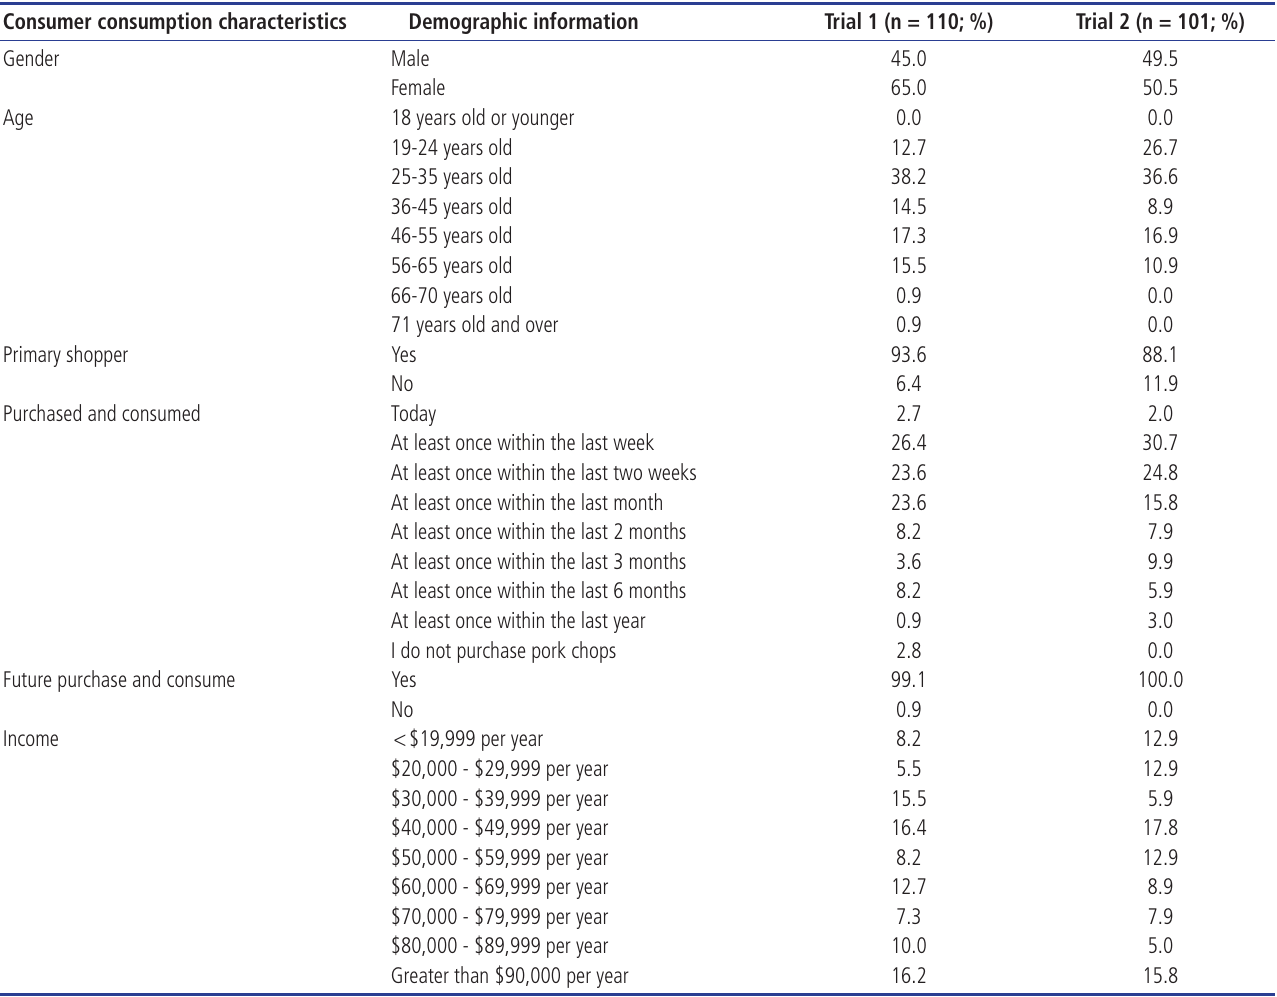
Table 2. Demographic information and consumer consumption characteristics for sensory tests on pork chops from pigs raised in an outdoor hoop